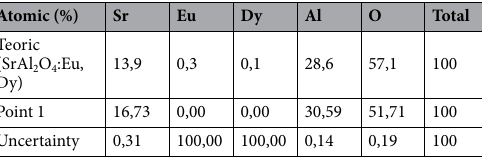
Table 1. Atomic % of the elements Sr, Al, O, Eu and Dy in the synthesized SrAl 2 O 4 :Eu, Dy phosphor heated at 1000 °C for 2 hour in 90N 2 -10H 2 atmosphere, employing a salt/SrAl 2 O 4 molar ratio of 3:1 as precursor alumina platelets with an average particle size, d 50 ≈ 6 μ m) and using SrAl 2 O 4 /SrO molar ratio of